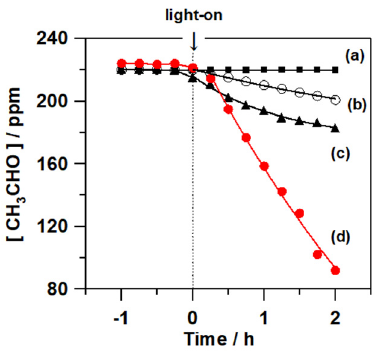
Figure 1. Time courses of decomposition of CH 3 CHO upon illumination in the presence of SnO 2 /SL-glass (a), TiO 2 /quartz (b), TiO 2 /SnO 2 /SL-glass (c), and pat-TiO 2 /SnO 2 /SL-glass (d). The figure is taken from ref. [26].